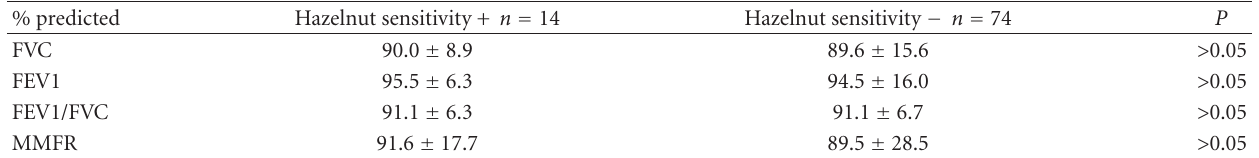
Table 4: Spirometric values of hazelnut